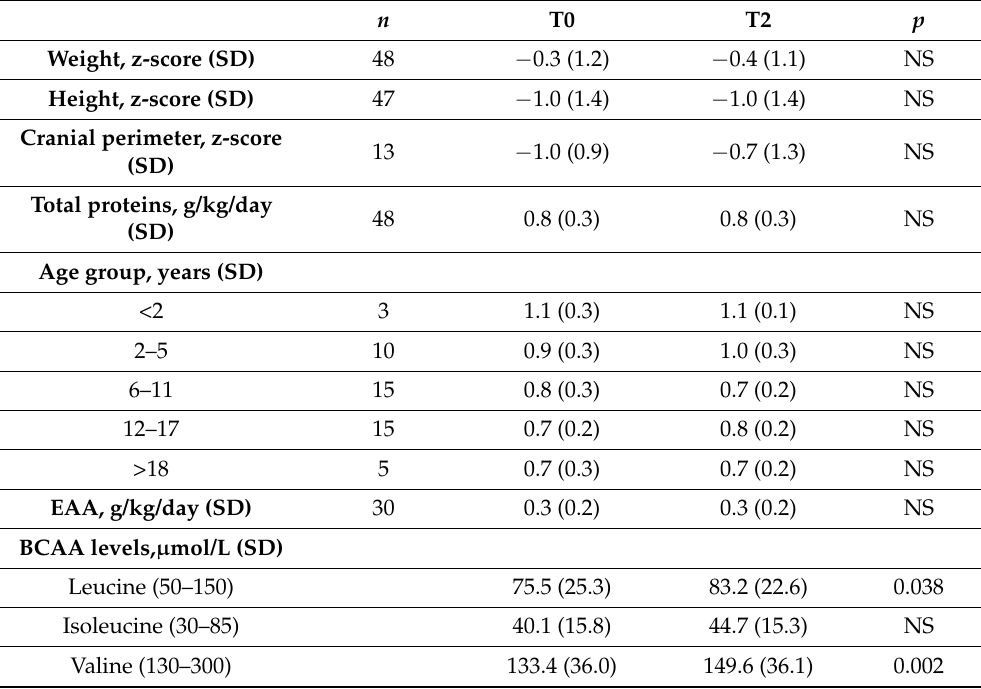
Table 3. Anthropometric values, dietary parameters, and BCAA